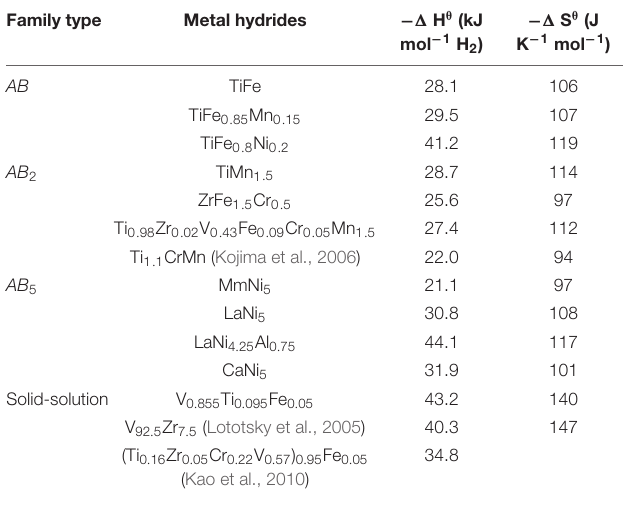
TABLE 4 | Enthalpy and entropy values of RT metal hydrides [obtained from ref (Sandrock, 1999) except for the ones cited in the table]. Family